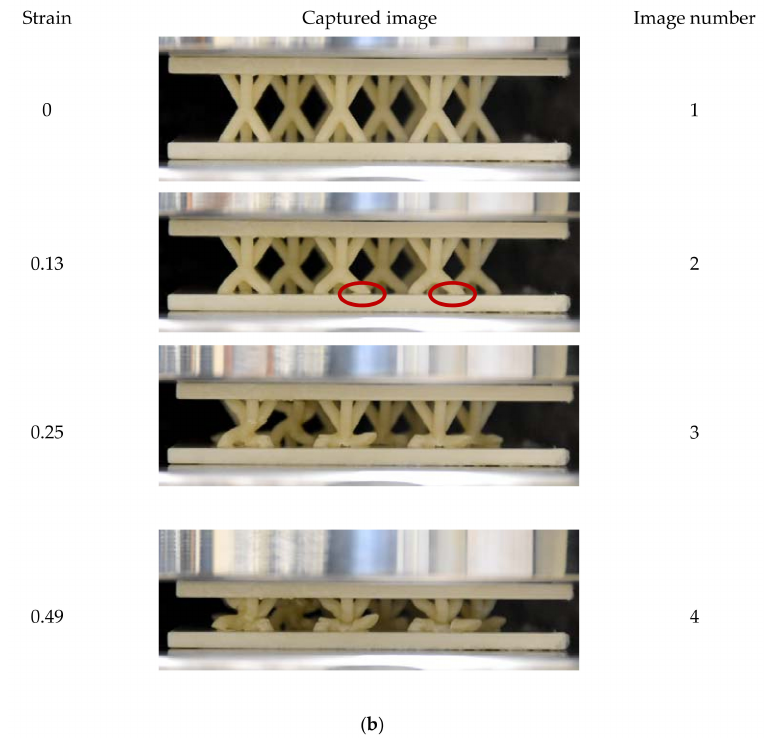
Figure 5. Compressive stress-strain graph of Kagome Structure and ( b ) images at di ff erent strain during compression.